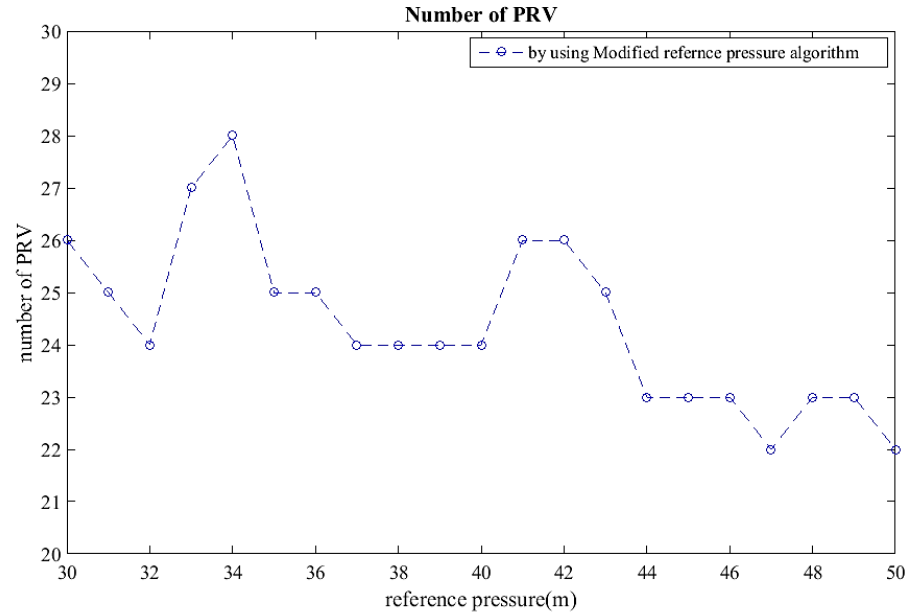
Figure 4. Number of pressure-reducing valves versus P ref .